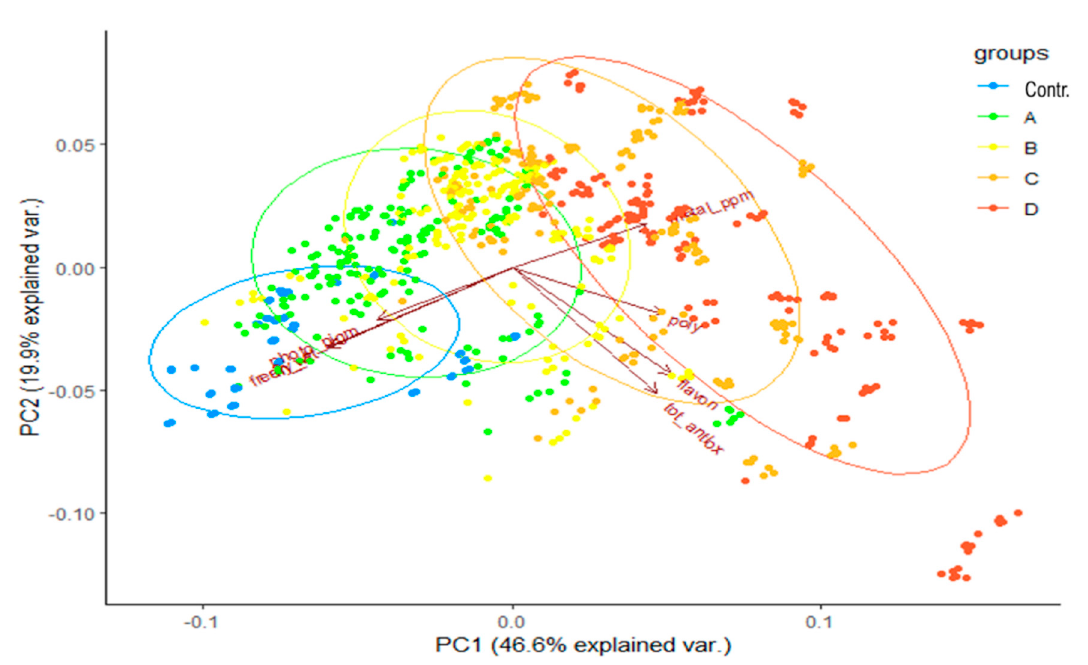
Figure 4. PCA analysis showing the grouping for P. aviculare data according to different metal treatments. The complete dataset reported in Supplementary Table S1 was used to perform the analysis by means of the prcomp function of the R package. Treatments: control, no metal; A, urban metal concentration; B, medium metal concentration, C, high metal concentration, D, maximum metal concentration allowing plant survival.